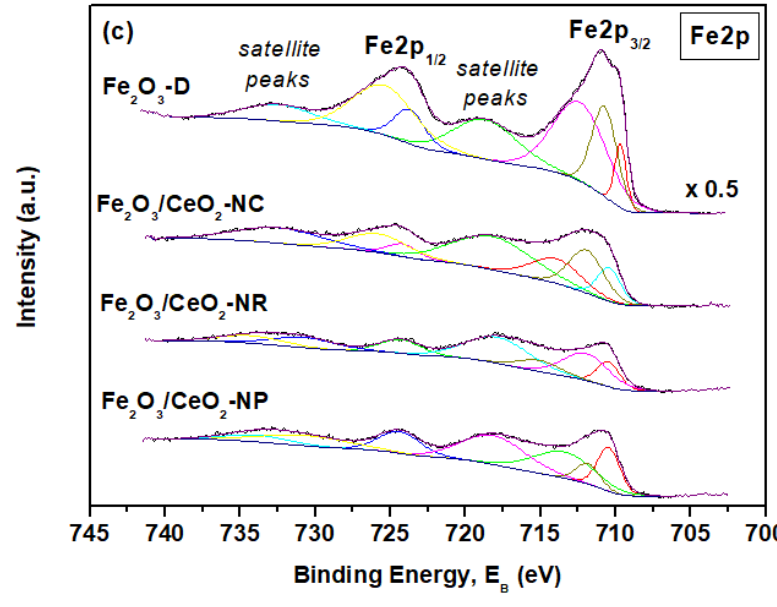
Figure 6. XPS spectra of ( a ) Ce 3d, ( b ) O 1s, and ( c ) Fe 2p of bare CeO 2 , Fe 2 O 3 -D, and Fe 2 O 3 /CeO 2 samples.